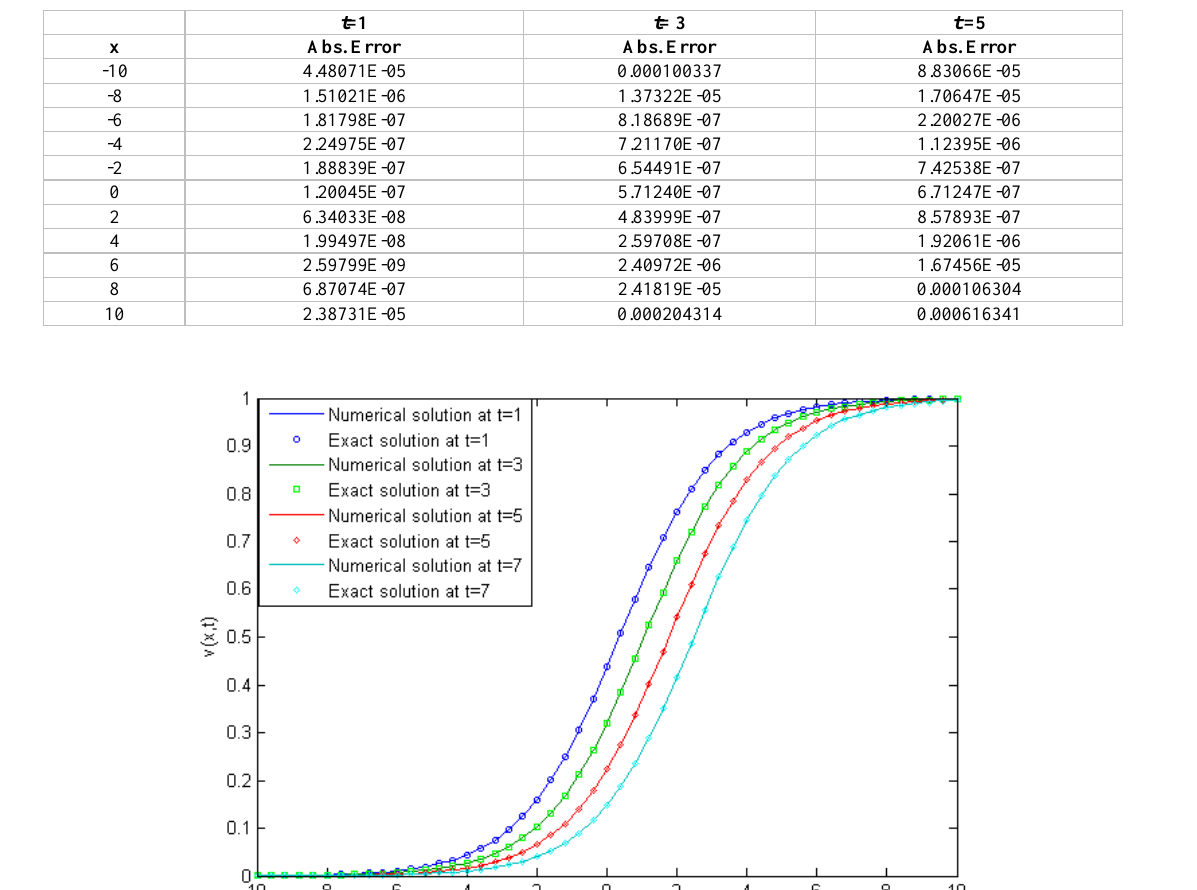
Table 2. Absolute errors obtained for Example 1 with N=51